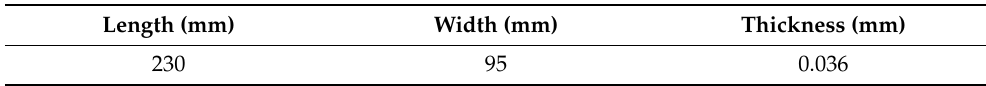
Table 3. Geometry details of the